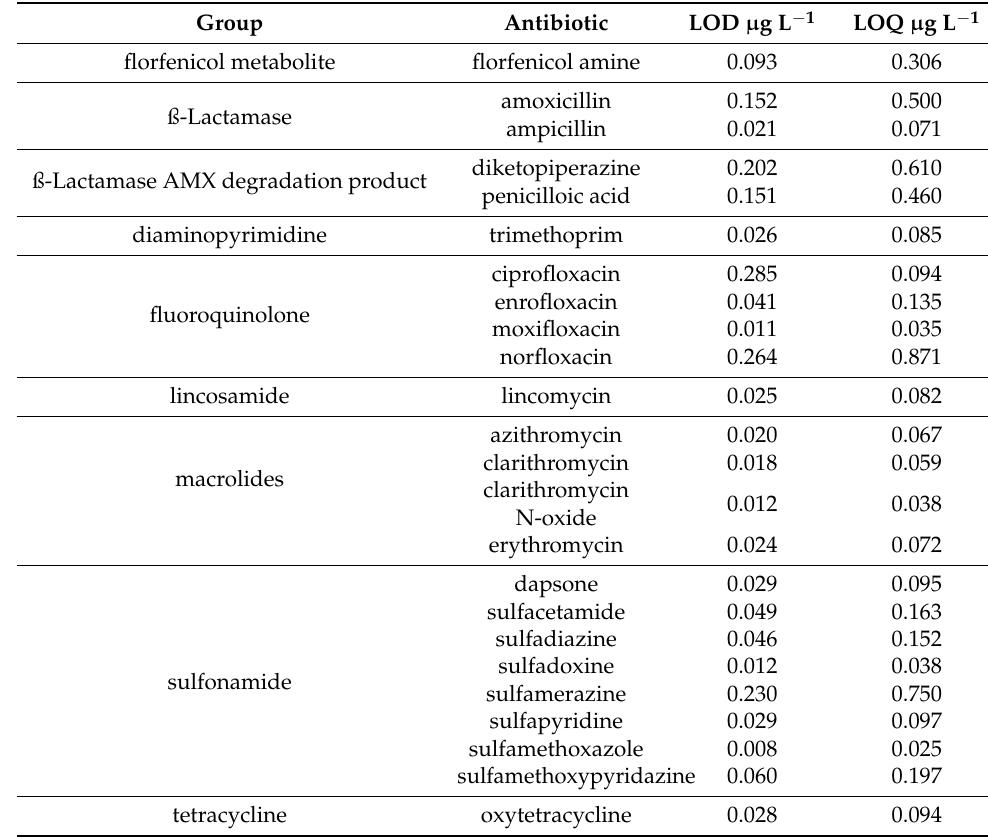
Table A2. LOD and LOQ values obtained for the studied antibiotics’ methodology.